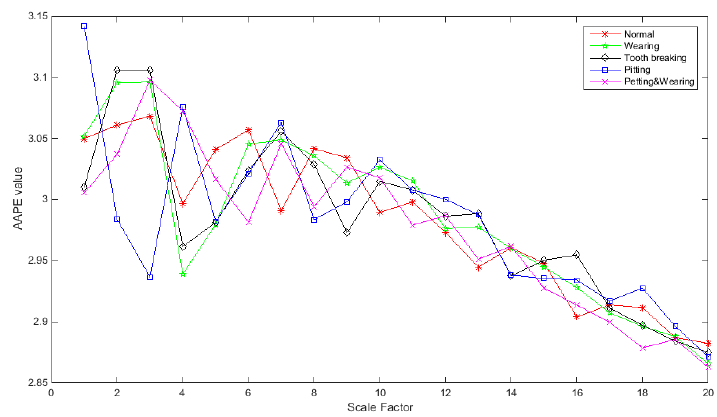
Figure 16. IMAAPE feature vectors for different fault types of the gearbox.